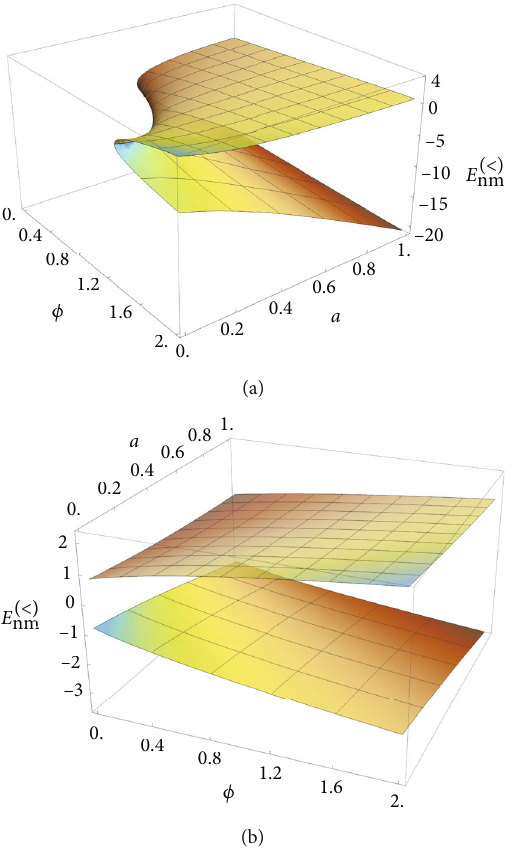
Figure 9: Sketch of the energy (Equation (71)) as a function of ϕ and a for n = 1 and m = 1 . In panel (a), α = 0 : 1 , and in panel (b), α = 0 : 9